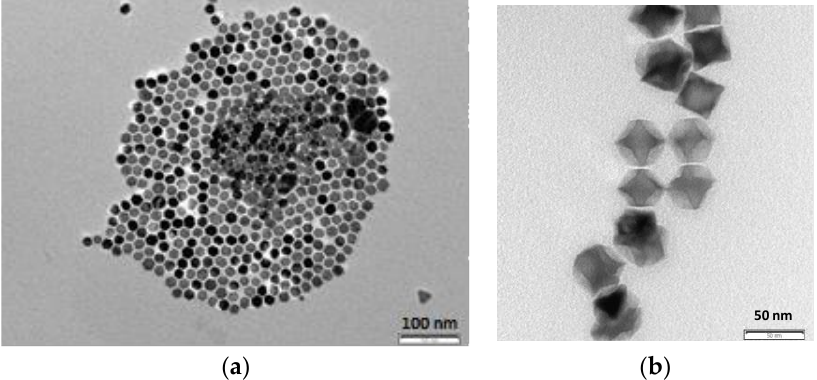
Figure 6. TEM images of ( a ) hydrophobic Fe 3 O 4 @OA NPs and ( b ) hydrophobic cubic Fe 3 O 4 @OA NPs, obtained by thermal decomposition method.